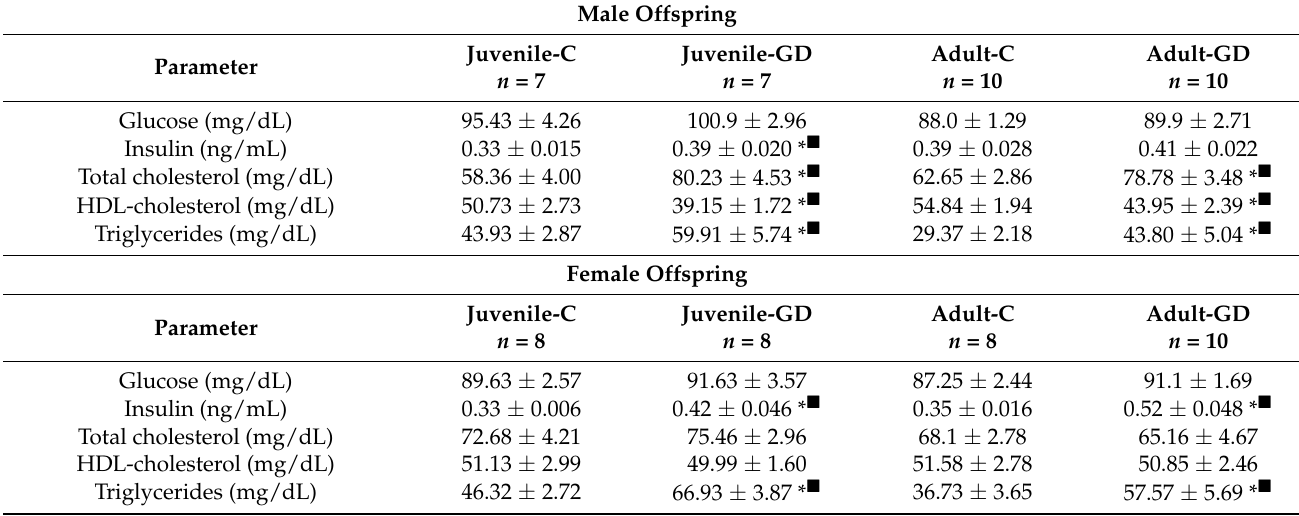
Table 4. Metabolic parameters in the serum of second-generation